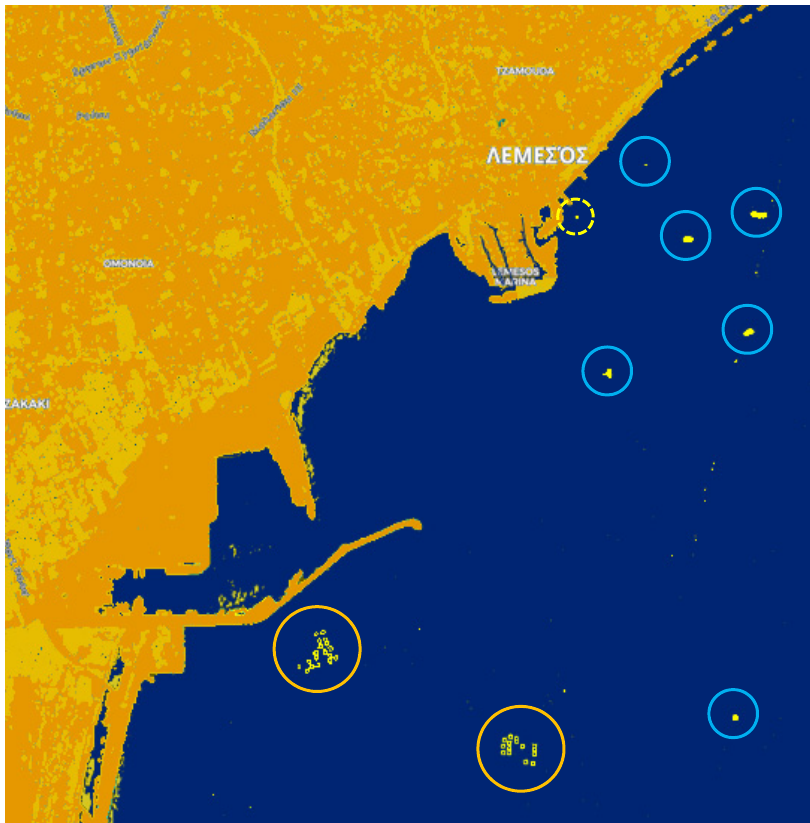
Figure 11. Plastic Index (PI) was used to identify the target, which is circled in yellow.